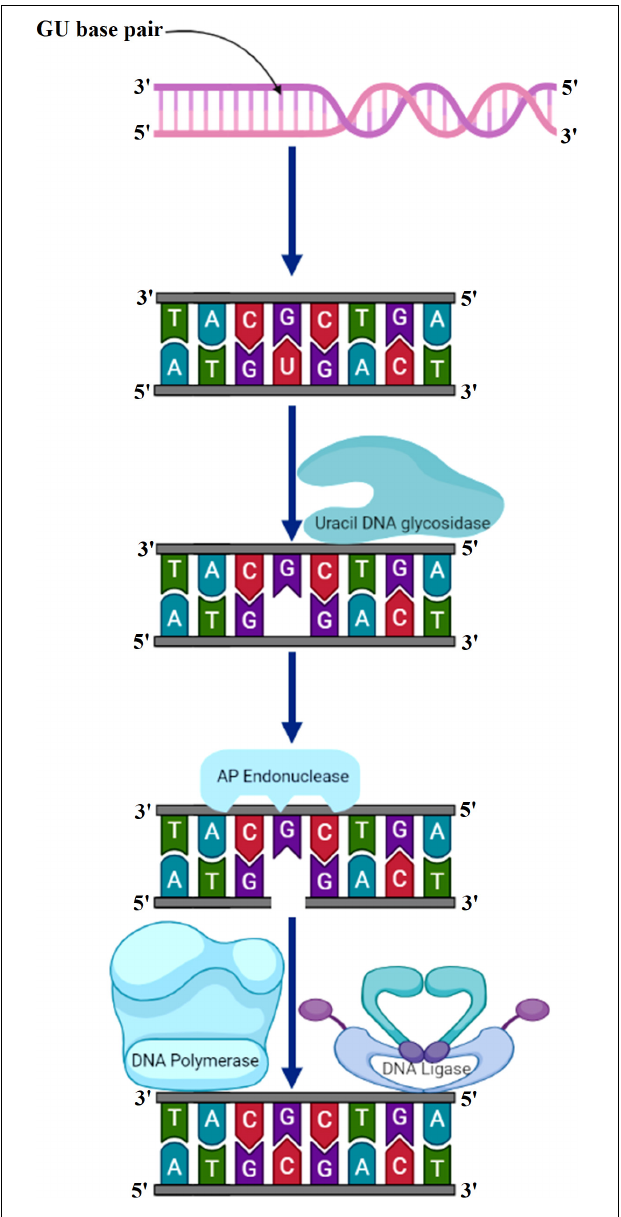
FIGURE 5 | Uracil bases in DNA, formed by the deamination of cytosine, are excised and replaced by cytosine by the combined action of uracil DNA glycosylase, AP endonuclease, DNA polymerase, and DNA ligase. AP,